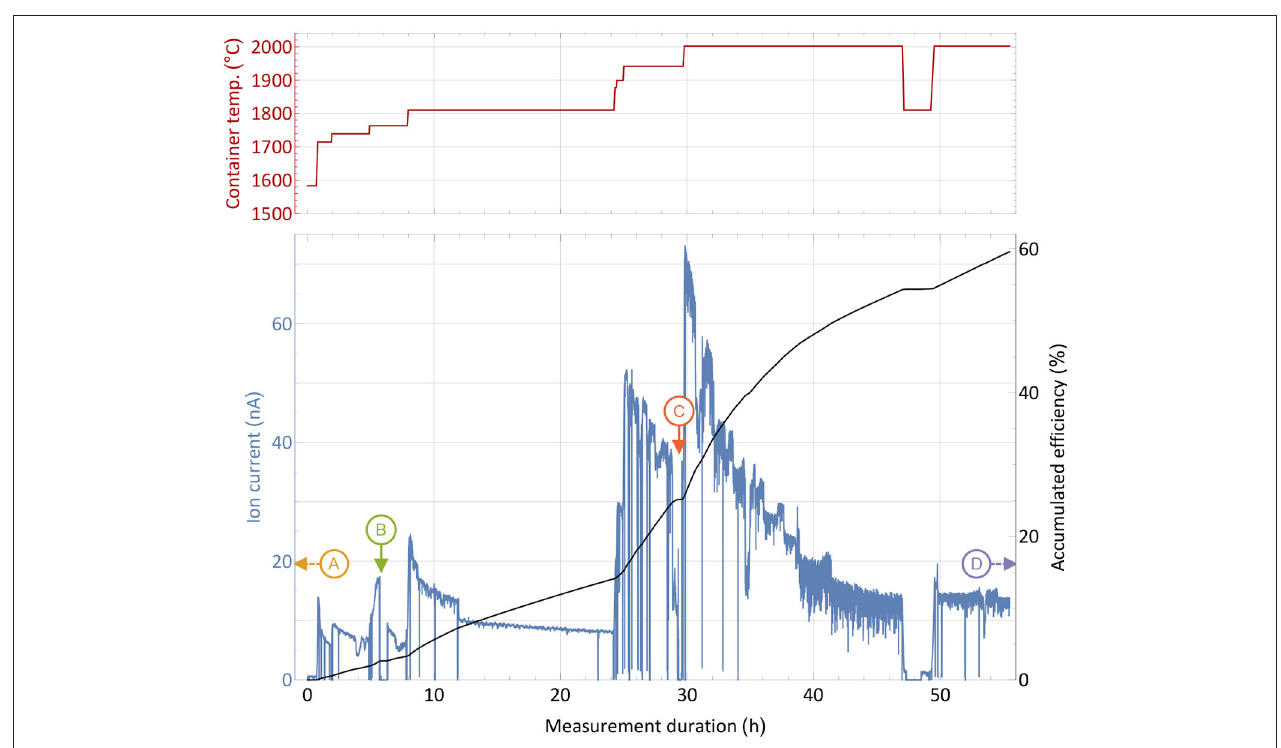
FIGURE 3 | Overall efficiency determination measurement with a 1,590nAh stable 169 Tm sample and a 10,000-fold nat Er 2 O 3 excess in a presentation analog to Figure 2 . Instants where the mass scans presented in Figure 4 were taken are marked with capital letters. The extracted ion current is shown with respect to the sample container temperature (top panel) over